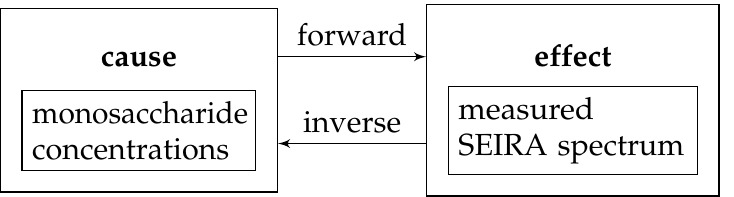
Figure 2. Flow chart visualising the forward/inverse problem of sensing with SEIRA spectroscopy of sugary solutions as an application